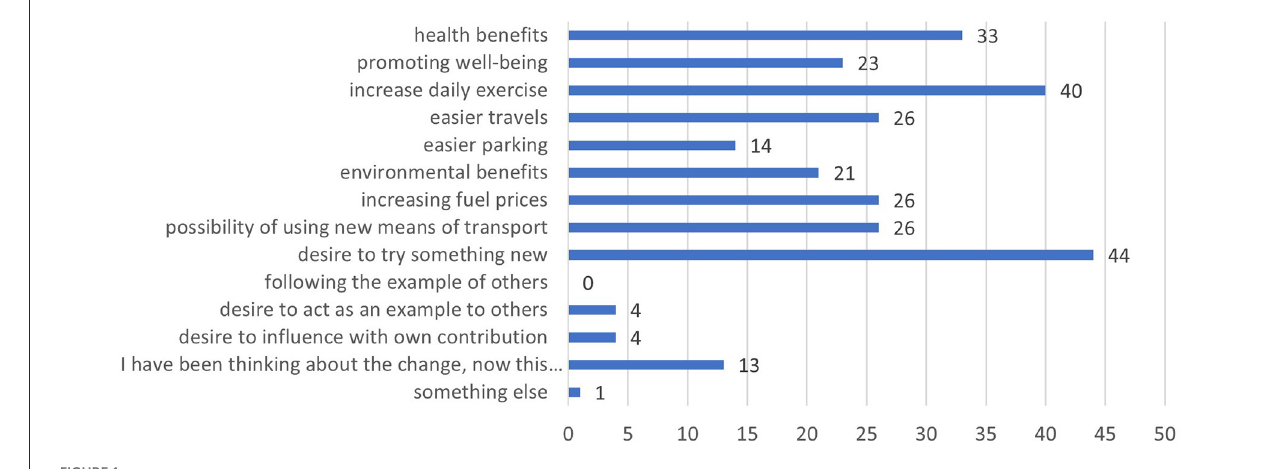
FIGURE1 Reasons to participate (initial survey, responses in